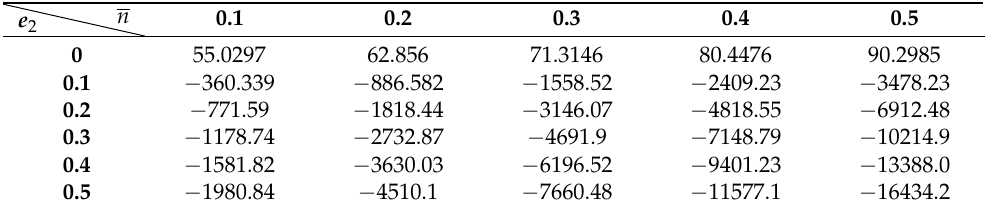
Table 5. Values for C f P r = 0.7, S c = 0.2.